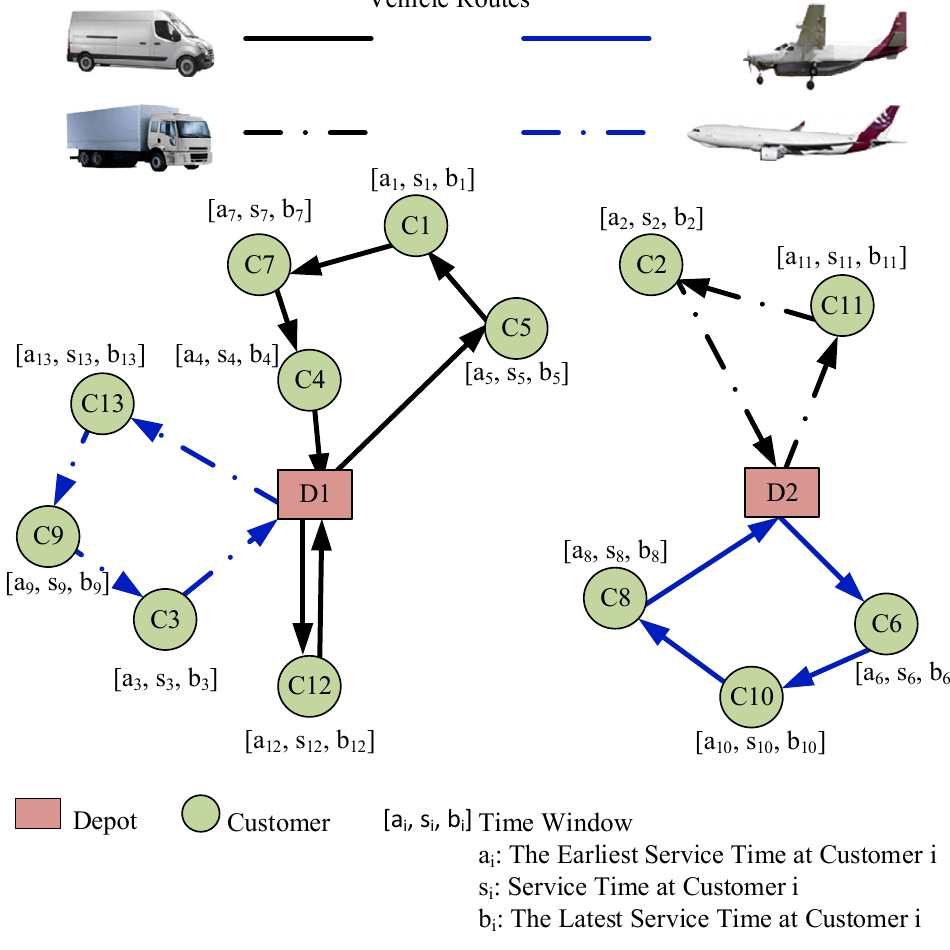
Fig. 2. The schematic representation of